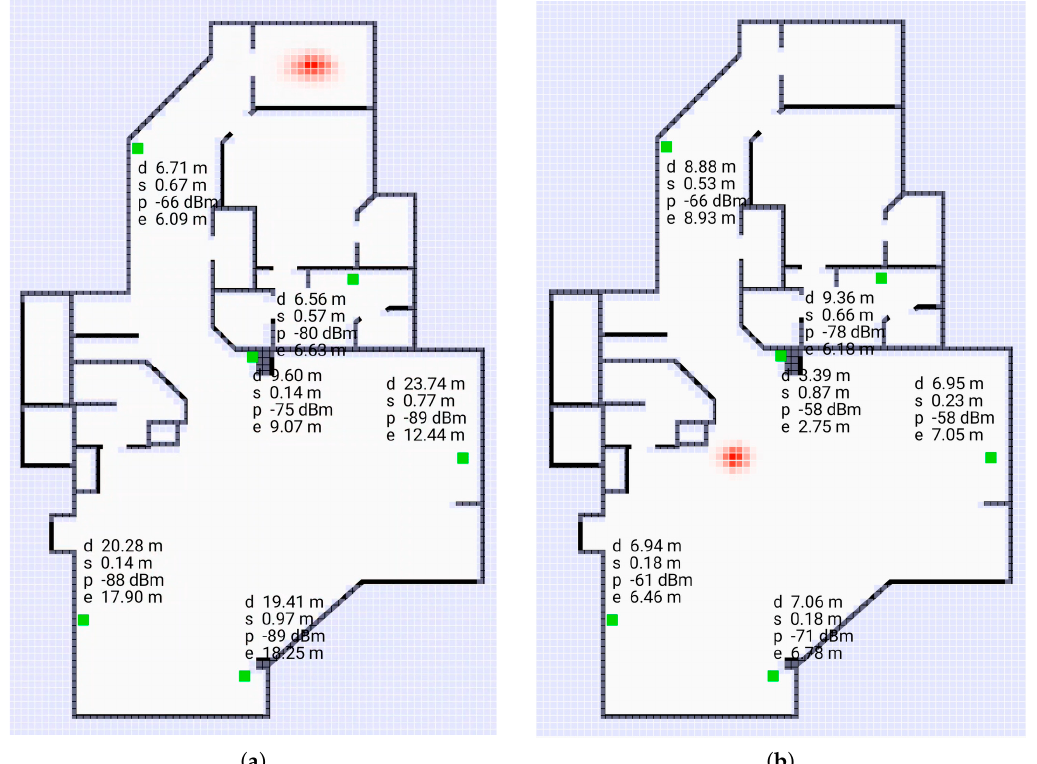
Figure 1. Screen shots of application using Bayesian grid update method as a “heat map” (from [29]). The cells here are 0.25 m on a side. The green spots are the responders. ( a ): initiator not far from centroid of responders, ( b ): initiator outside convex hull of responders. The “hot spot” (red) in ( b ) is larger than the one in ( a ). Note that the paths between initiator and responder typically passes through one or more walls or other obstacles. The grid update method uses the observation model developed